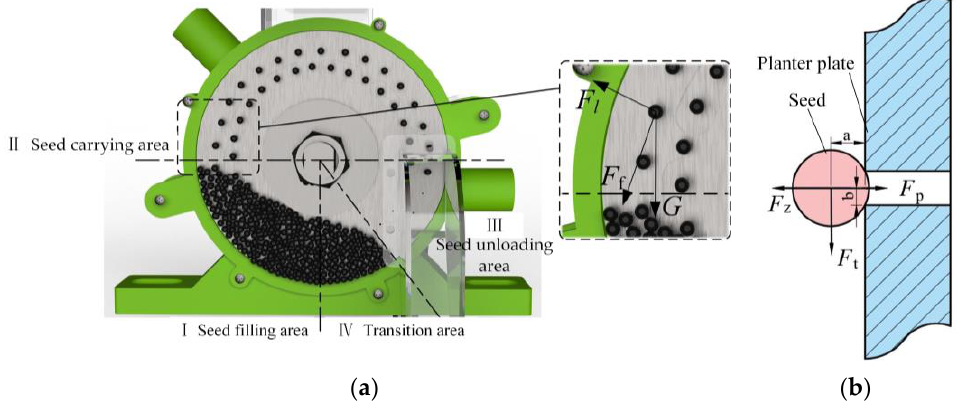
Figure 6. Force analysis diagram of an adsorbed seed. ( a ) Force analysis in the xy plane; ( b ) Force analysis in the yz plane.